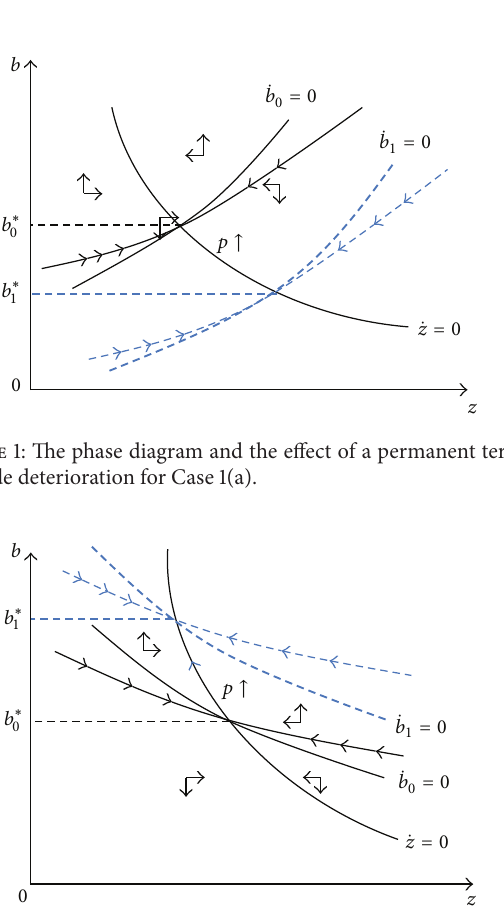
Figure 2: The phase diagram and the effect of a permanent terms- of-trade deterioration for Case